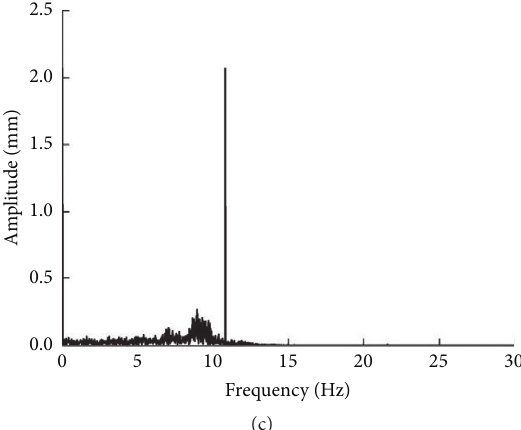
Figure 17: Chaotic motion of the system is obtained for the external excitation frequency Ω � 10 . 8 Hz: (a) waveform; (b) phase portrait; (c) amplitude spectrum.